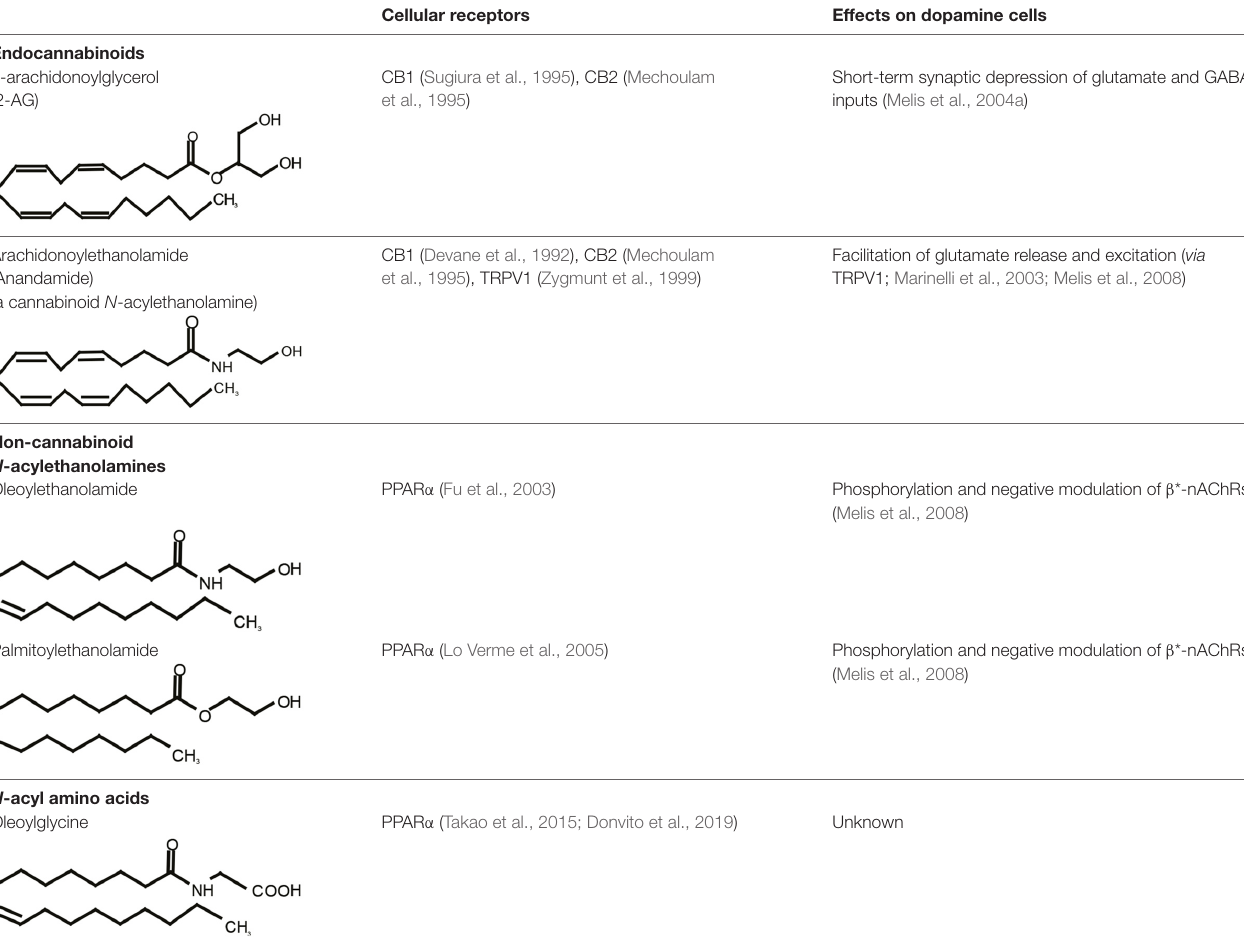
TABLE 1 | Representative bioactive neural lipids, their cellular receptors, and their cellular effects on dopamine